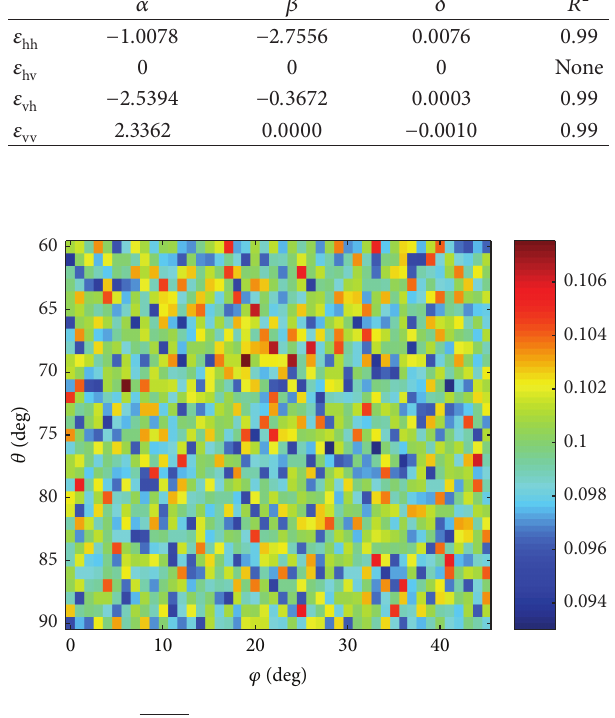
Figure 6: |𝑍 𝑏 DR | in dB with |𝛿 𝑖𝑗 | = 0 . 01, |𝛼 𝑖𝑗 |,|𝛽 𝑖𝑗 | ∼ 𝑈( 0 , 2 ) .